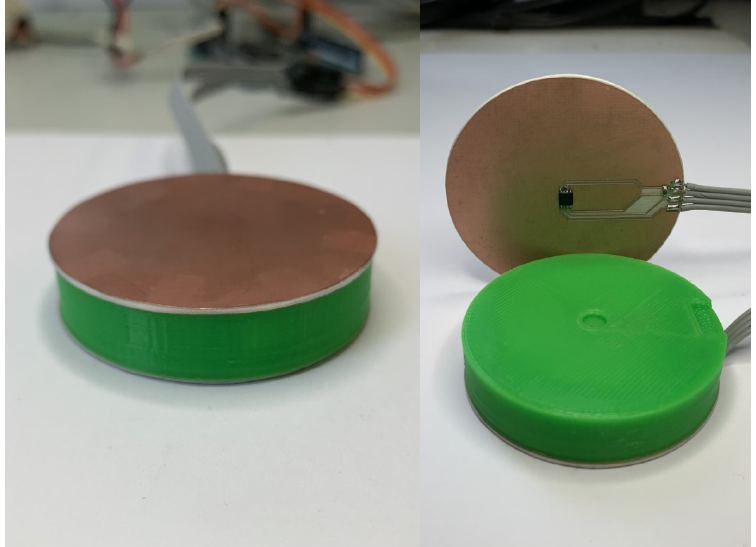
Figure 6. Heat flux sensor